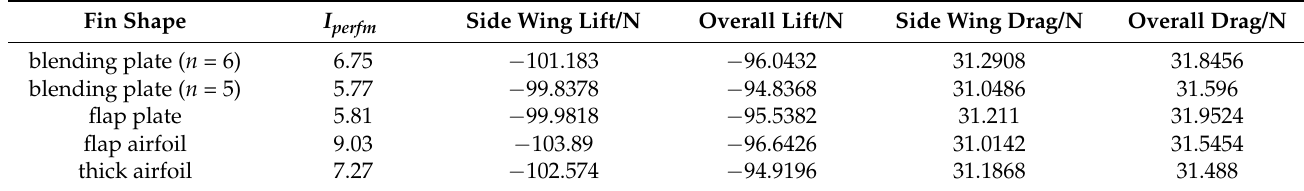
Table 3. Simulation results of fin shape optimization (15